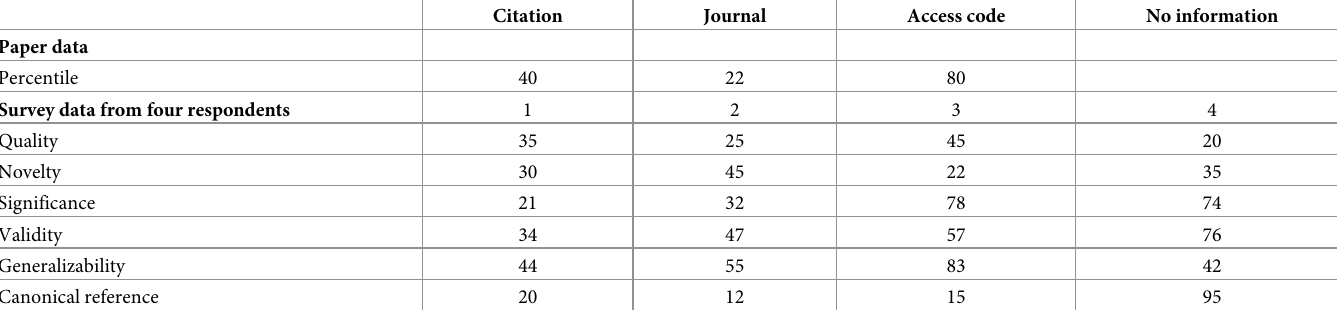
Table 1. Fictitious data that are paper-based (e.g. the citation percentile) or respondent-based (e.g. the quality assessment).